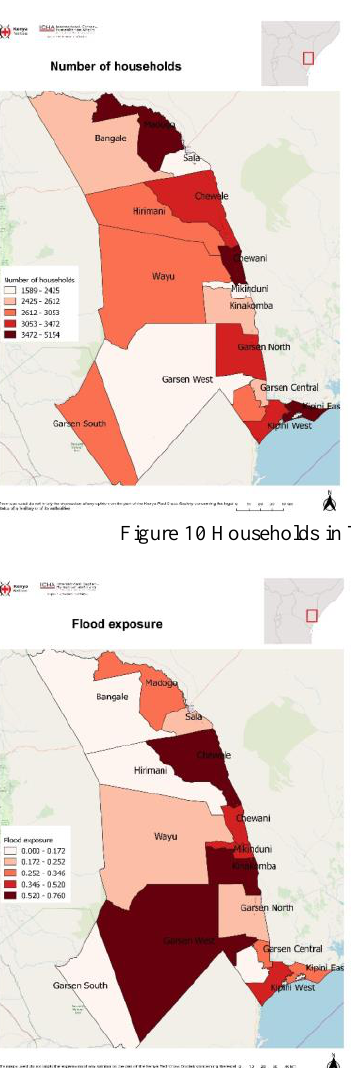
Figure 11 Tana river flood exposure From the flood exposure layer, Garsen west, Kinakomba and Chewele are the most flood exposed wards in Tana